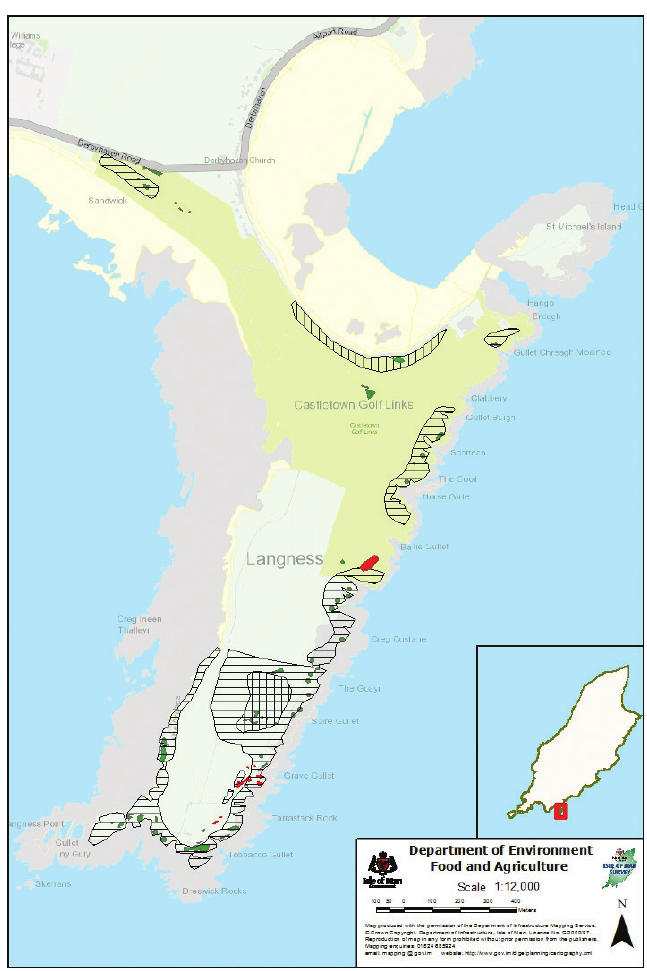
Fig. 2. Aerial photograph of Langness, showing the area covered by the golf course (light green), the distribution of S. stigmaticus in August 1964 (vertical hatching), 1990 (horizontal hatching), and sites occupied from 2002 in the absence of grazing (dark green) and sites occupied from 2002 where grazing had been re- introduced (red) (based on mapping by Mr. J. F. Burton reported in RPS Clouston (1990), Cherrill (1990, 1994) and subsequent observations by the